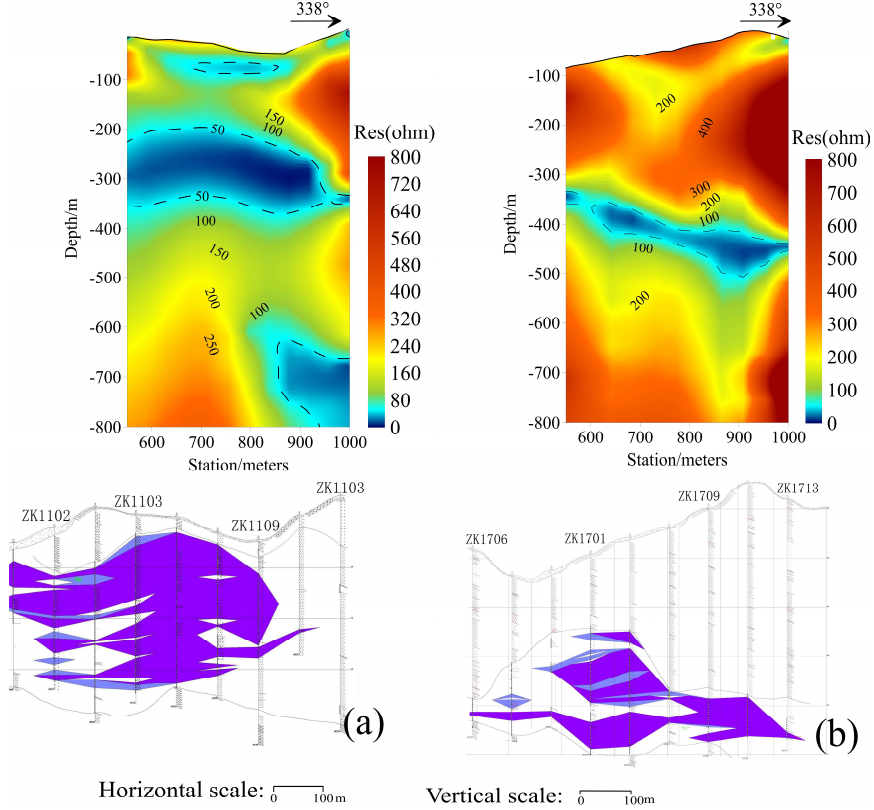
Figure 9. Resistivity-inversion section and geology sections for L11 and L17: ( a ) L11; ( b ) L17.